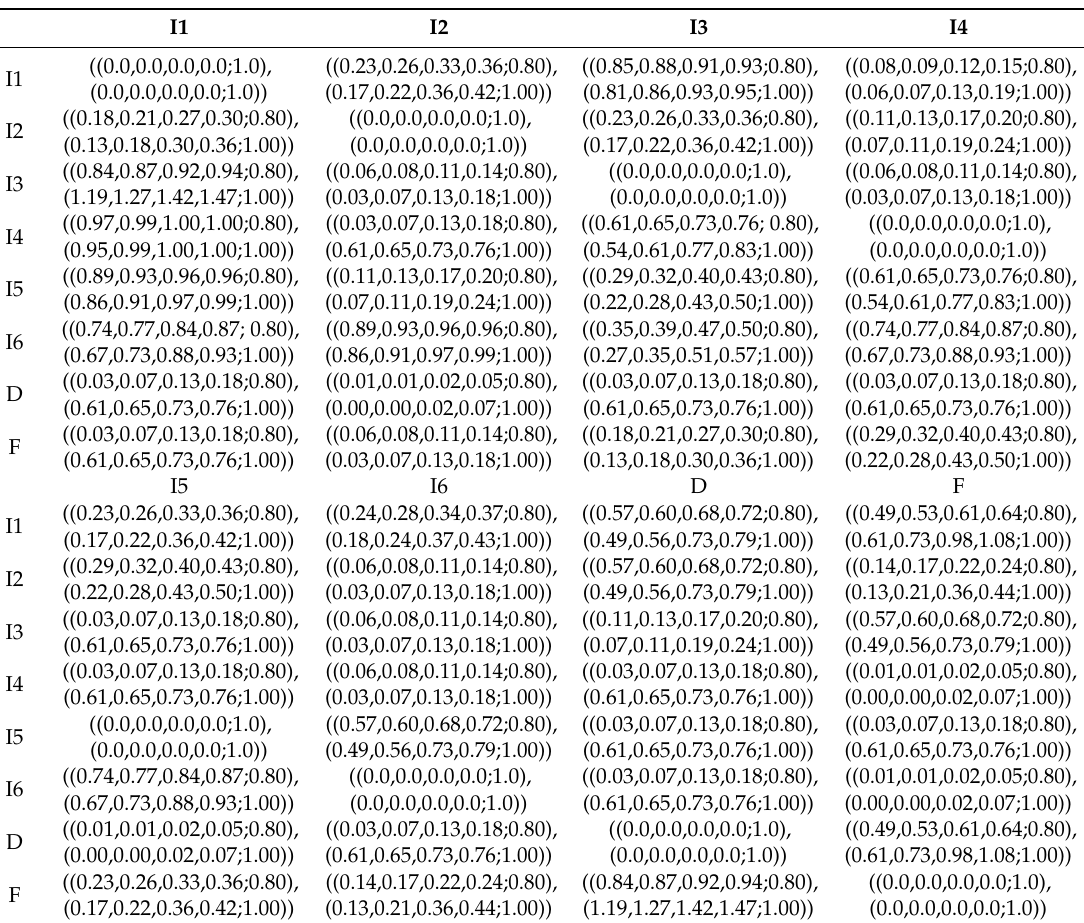
Table A8. Fuzzy relation matrix.